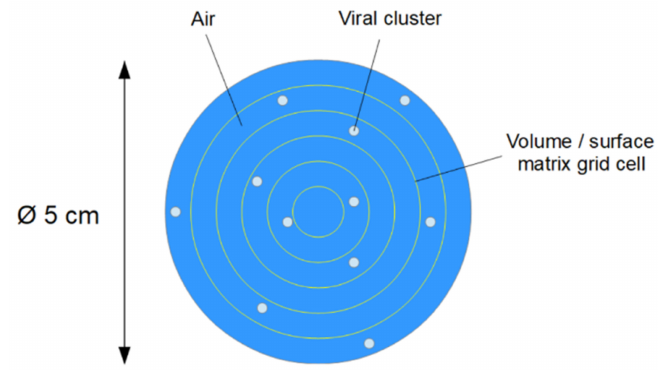
Figure 5. Geometrical model x–z section.